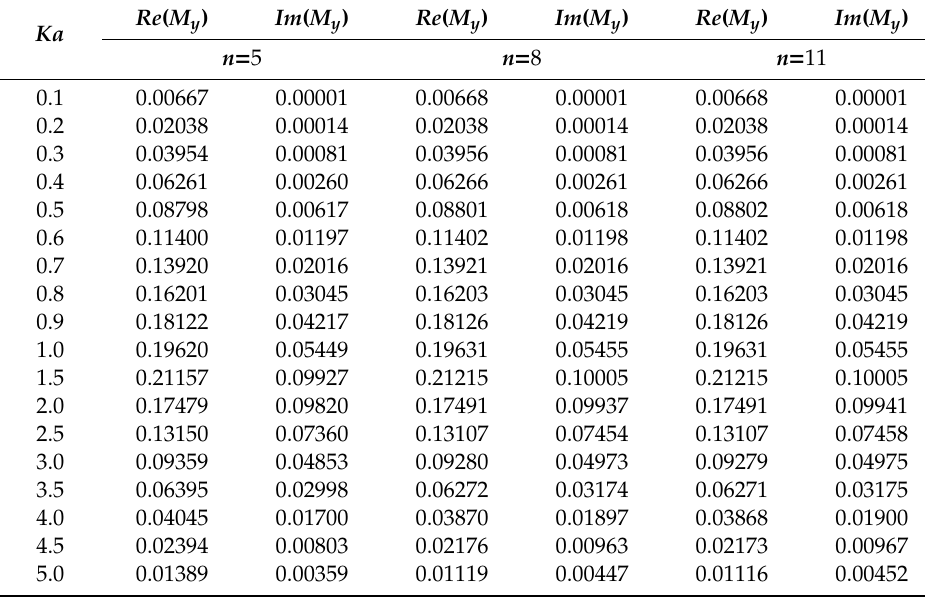
Table 3. Convergence sequence of the computations in terms of the real and imaginary parts of the normalized pitch moment M y / ρ gAa 3 for di ff erent mode numbers. Slenderness of the oblate spheroid is b / a = 0.8 with an immersion of f / a = 1.0. The normalization in that of Equation